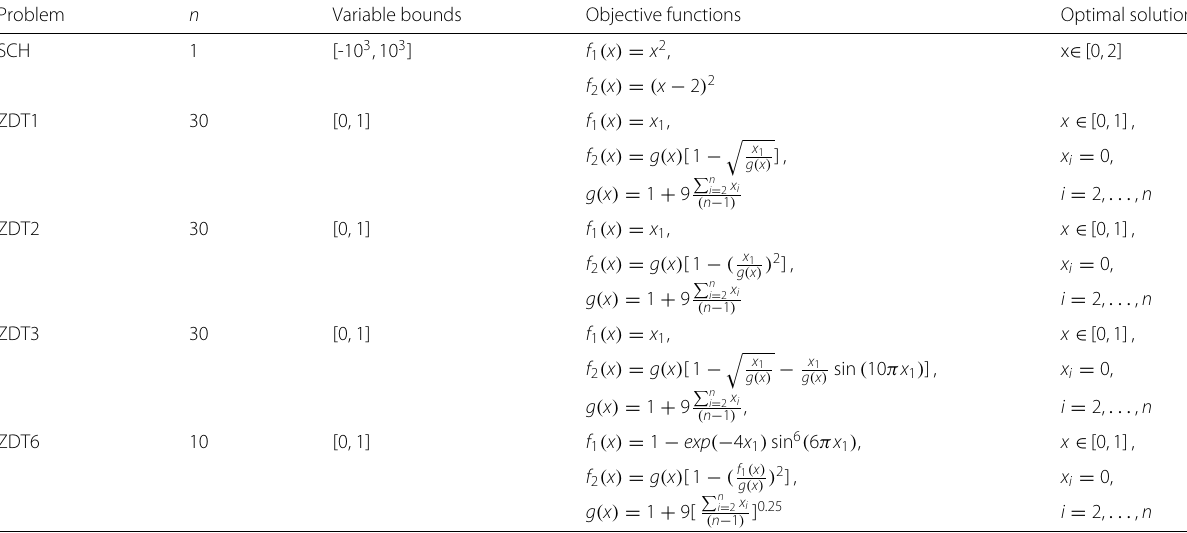
Table 1 Constrained test problems used in the evaluation (all objectives are to be minimized) Problem n Variable bounds Objective functions Optimal solutions